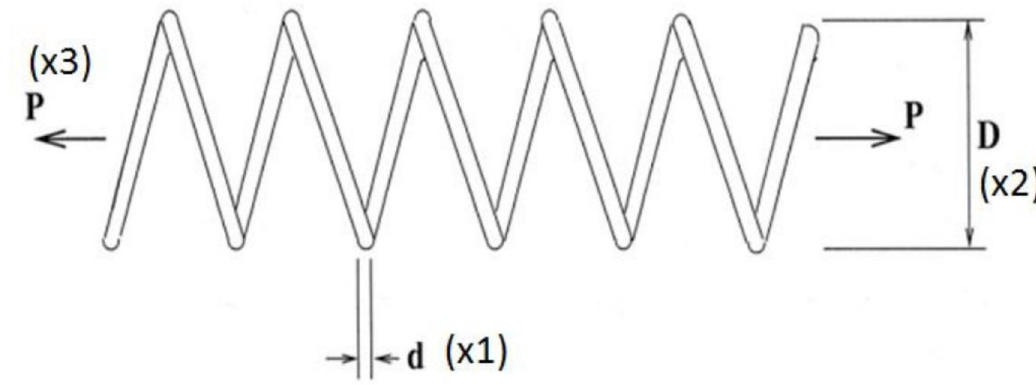
Fig 8. Compression spring design problem [27].